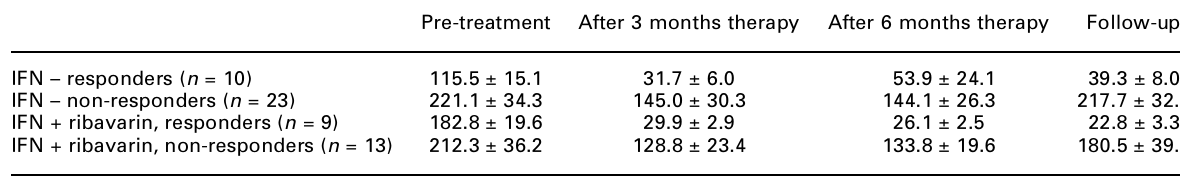
Table 1. ALT levels